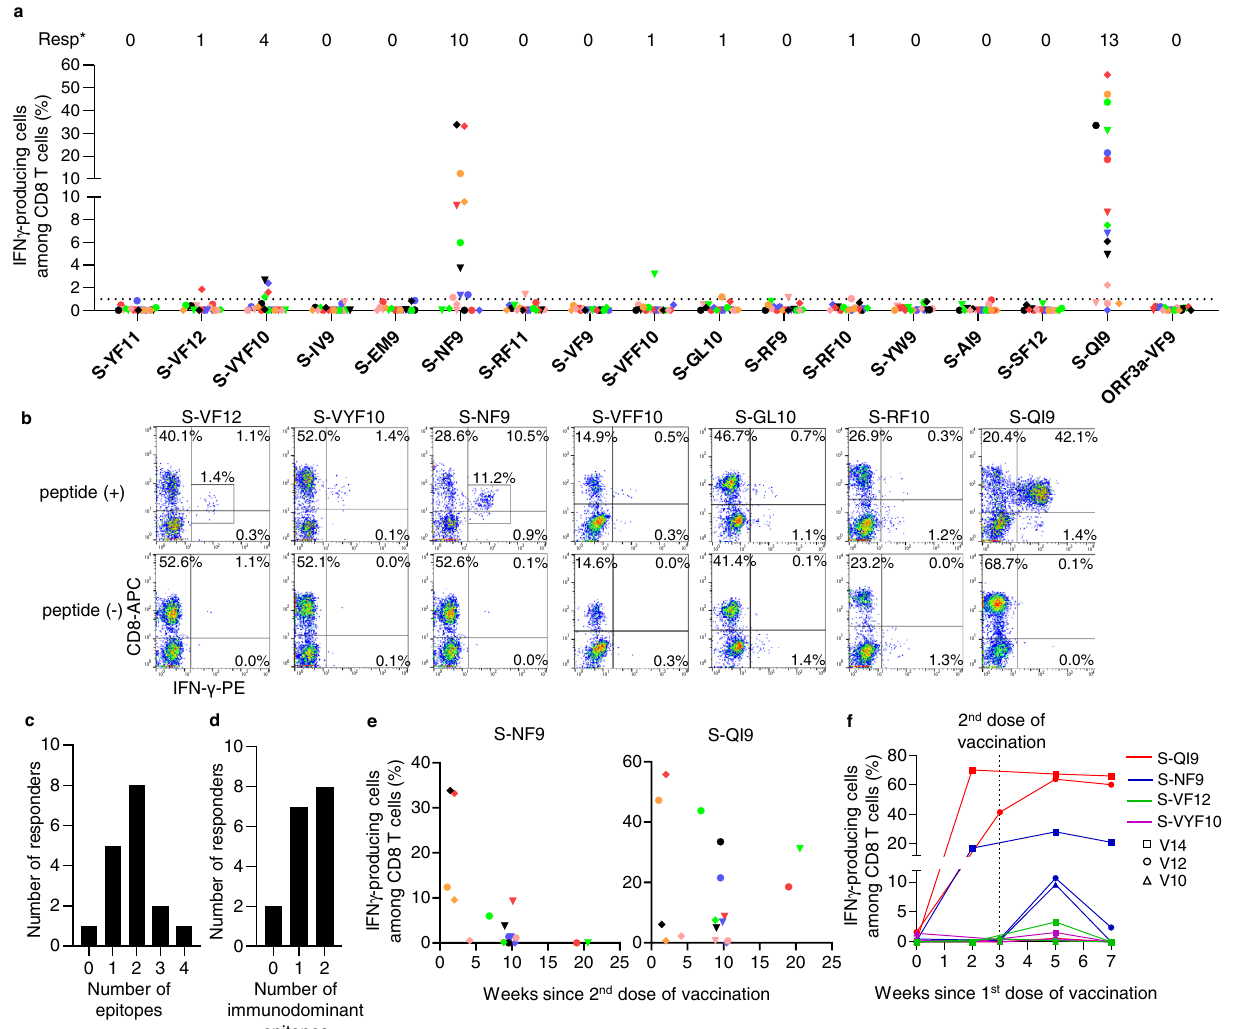
Fig. 1| InductionofHLA-A*24:02-restrictedCD8 + Tcellsspeci fi c forSARS-CoV- 2 spike epitopes in HLA-A*24:02 + individuals vaccinated with an mRNA vac- cine. HLA-A*24:02-restricted T cell responses to SARS-CoV-2 spike epitopes were analyzedinHLA-A*24:02 + individualswhoreceived2dosesoftheBNT162b2mRNA vaccine. HLA-A*24:02-restricted, SARS-CoV-2 spike-speci fi c bulk T cells were gen- erated by stimulating peripheral blood mononuclear cells (PBMCs) from 17 HLA- A*24:02 + , vaccinated individuals with peptide cocktails containing 5 or 6 HLA- A*24:02-restricted SARS-CoV-2 spike peptides or an ORF3a epitope and then cul- turing the cells for 2 weeks. Responses of the bulk T cells to C1R-A2402 cells pre- pulsed with 1 μ M of each peptide were analyzed by ICS assays. a Frequency